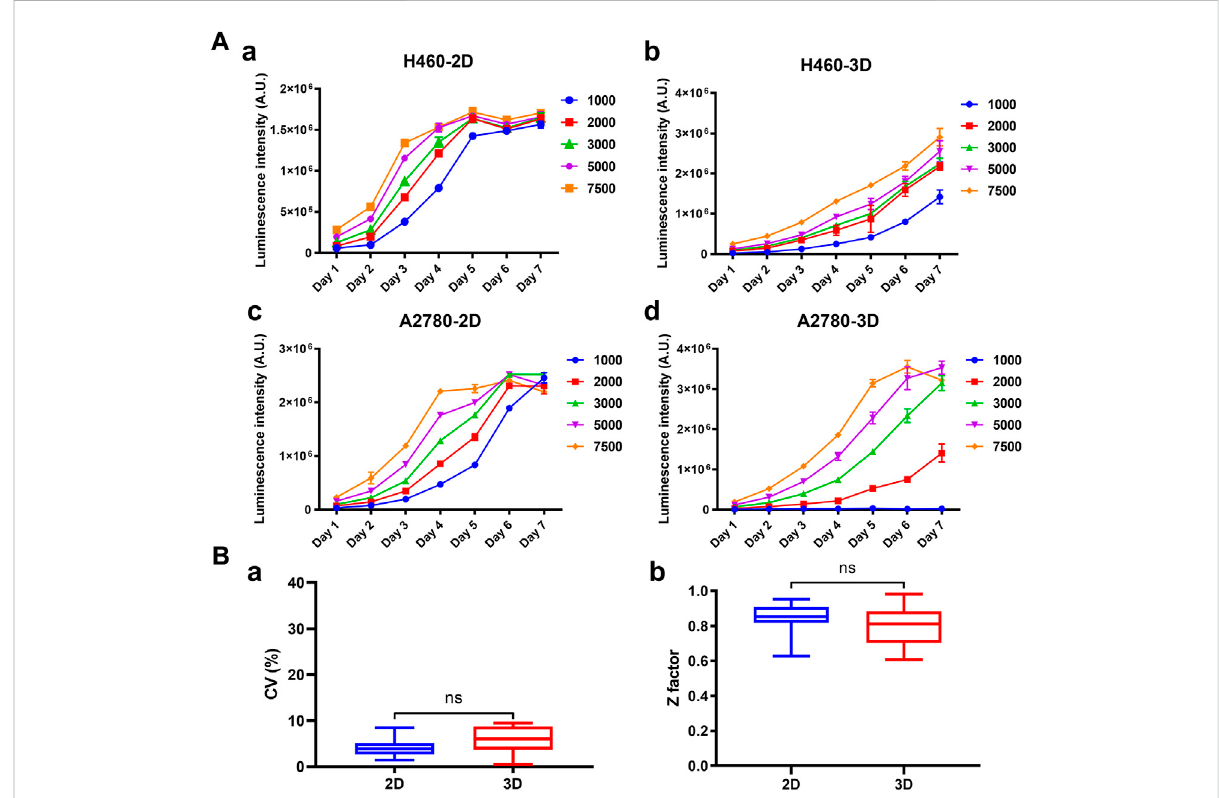
FIGURE 3 Growth curves and robustness of the 2D and 3D models. (A) Cell growth curves of H460 and A2780 cells cultured on the 2D and 3D models were characterized at different seeding densities. Cell viability was indicated by luminescence intensity measured using CellTiter-Glo. (B) Comparison of the statistics values of coef fi cient of variation (CV) and Z ′ factor between the 2D and 3D models. All data are presented as means ± SD of three